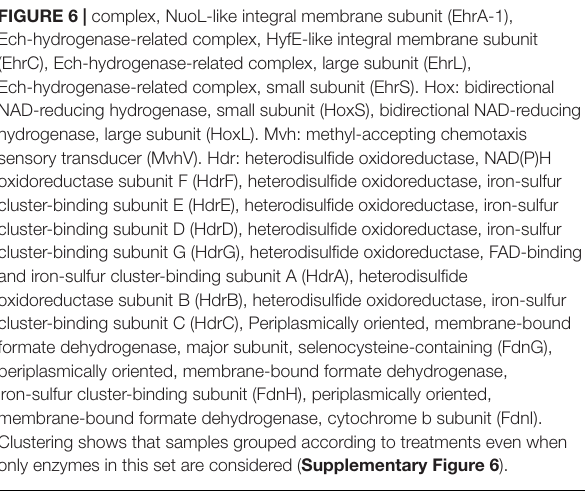
FIGURE 6 | complex, NuoL-like integral membrane subunit (EhrA-1), Ech-hydrogenase-related complex, HyfE-like integral membrane subunit (EhrC), Ech-hydrogenase-related complex, large subunit (EhrL), Ech-hydrogenase-related complex, small subunit (EhrS). Hox: